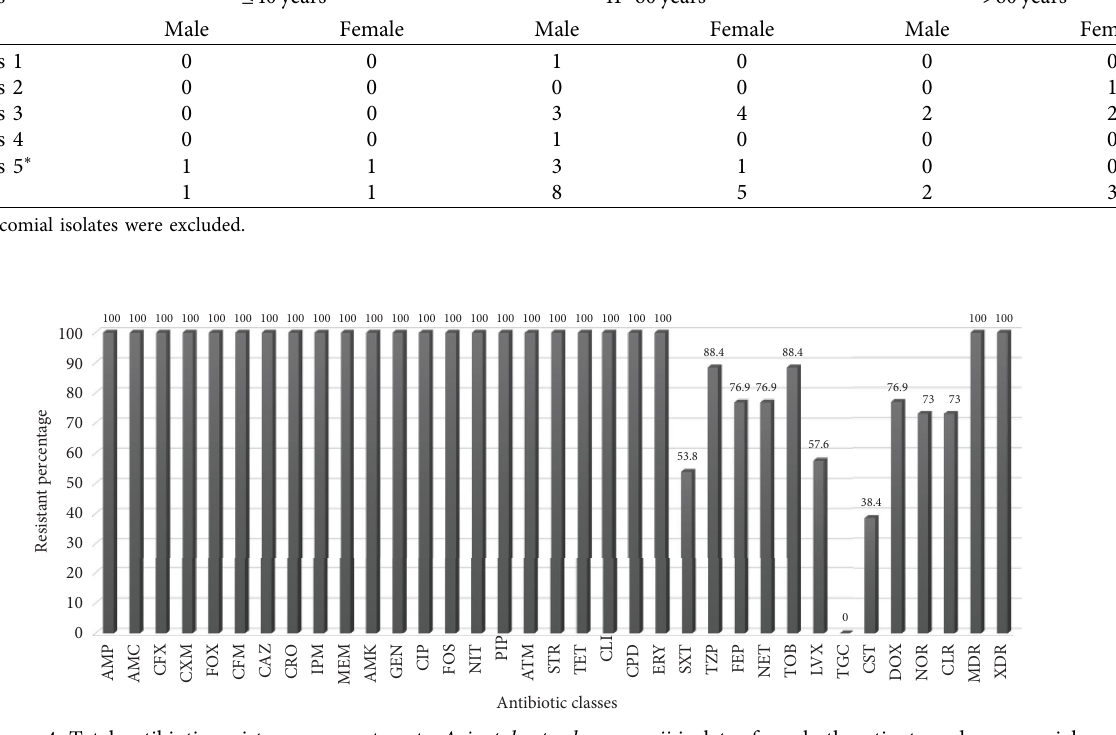
Figure 4: Total antibiotic resistance percentage to Acinetobacter baumannii isolates from both patients and nosocomial. Table 5: Antibiotic resistance pattern to Acinetobacter baumannii isolates.